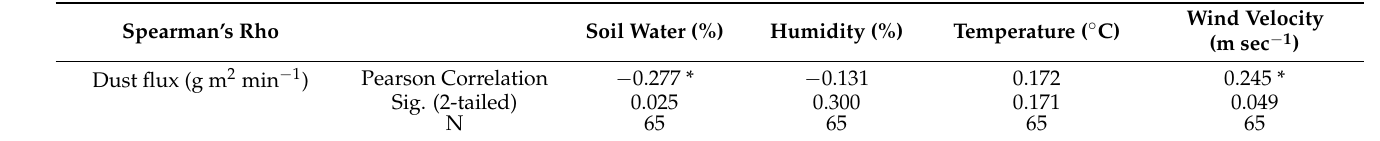
Table 3. Spearman rank coefficient for environmental